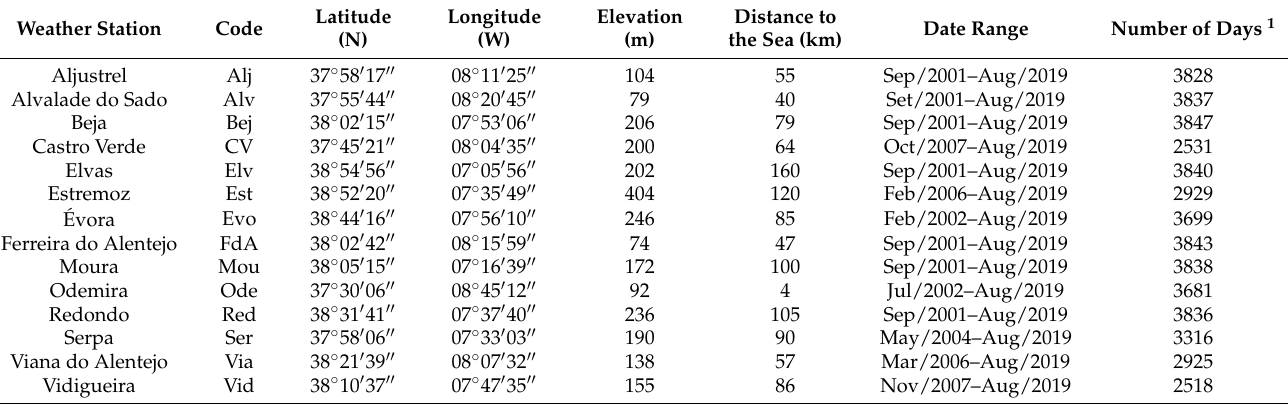
Table 1. Weather stations coordinates, elevation, distance to the sea, and date ranges of the weather data series. Weather Station